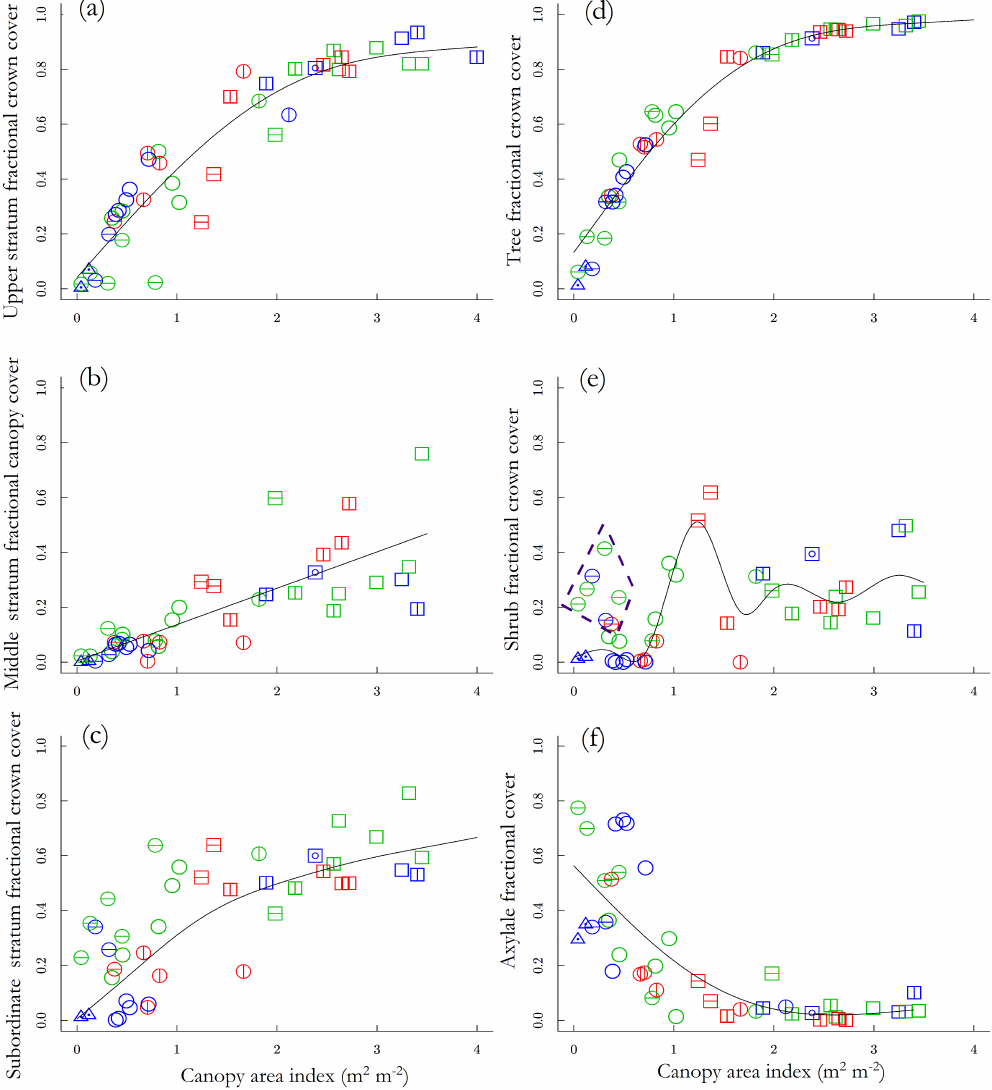
Figure 3. Relationship between various measures of canopy structure and woody plant canopy area index. The three left hand side panels are separated by the woody vegetation forms according to stratum, viz. upper, middle and subordinate; the three right hand panels are separated according to physiognomic form, viz. trees, shrubs and axylales (i.e. herbs and grasses). (a) Upper stratum is ,all trees with D > 0 . 1m; (b) middle stratum is all trees and shrubs (25mm < D < 0 . 1m and H > 1 . 5m); (c) subordinate stratum is ,all tree and shrub species ( H > 1 . 5m); (d) all tree species (including seedlings); (e) all shrub species (including seedlings) and (f) non-woody plants (axylales). Symbols as in Fig. 1. The fitted lines represent a quadratically penalised generalised general linear model fit which for (d) and (e) excludes the shrubby savannas (enclosed in the dotted-lined polygon in (e) ; see also